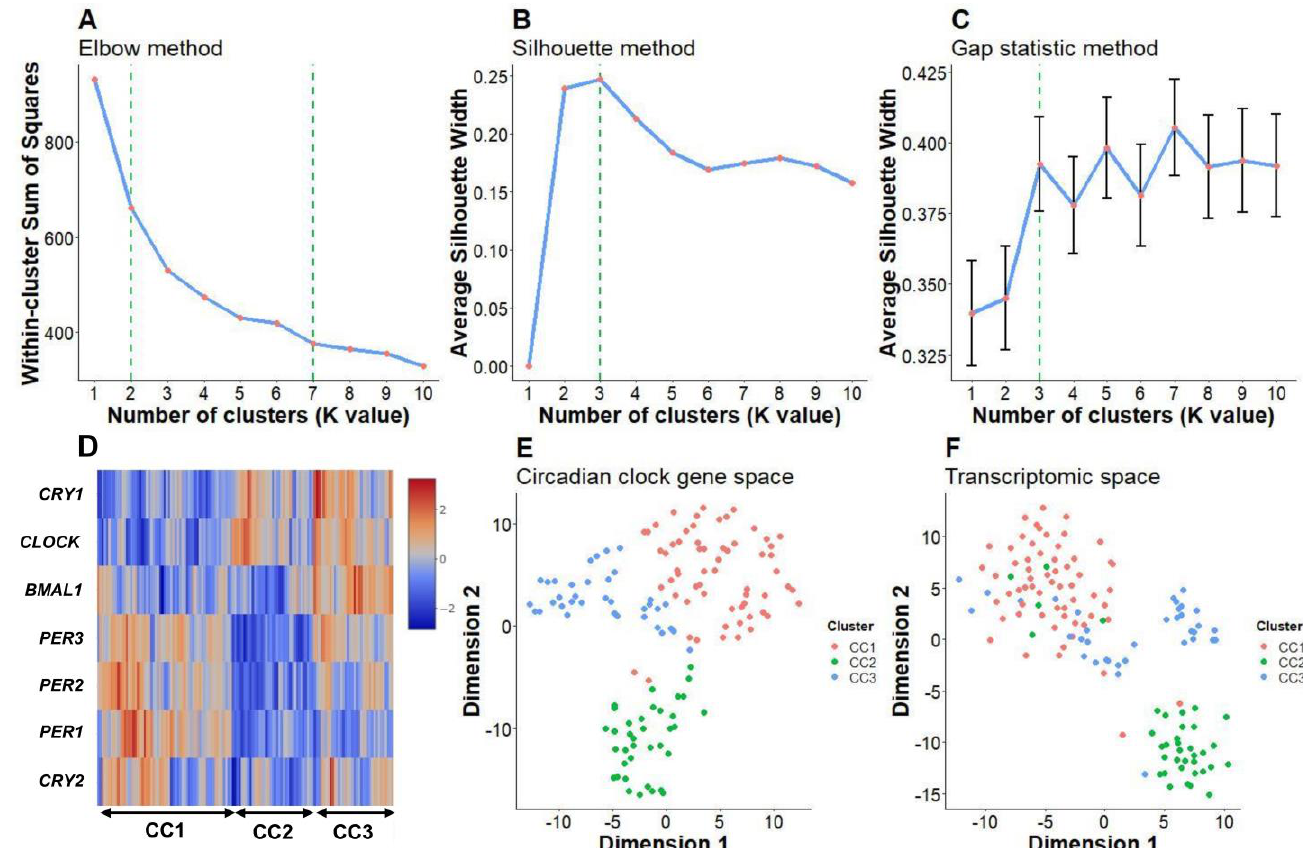
Figure 1. ( A ) The elbow method showing significant drops in WSS from K = 2 to K = 7, while the silhouette and gap statistic methods suggest that K = 3 is the optimal value ( B , C ), which leads to the consensus of K = 3 as the optimal number of CC clusters in patients with asthma. ( D ) Heatmap showing the expression pattern of the core clock genes; t-distributed stochastic neighbor embedding (t-SNE) dimension reduction illustrates that the three CC subtypes formed a distinct cluster in both circadian clock space ( E ) and whole transcriptomic space ( F ).